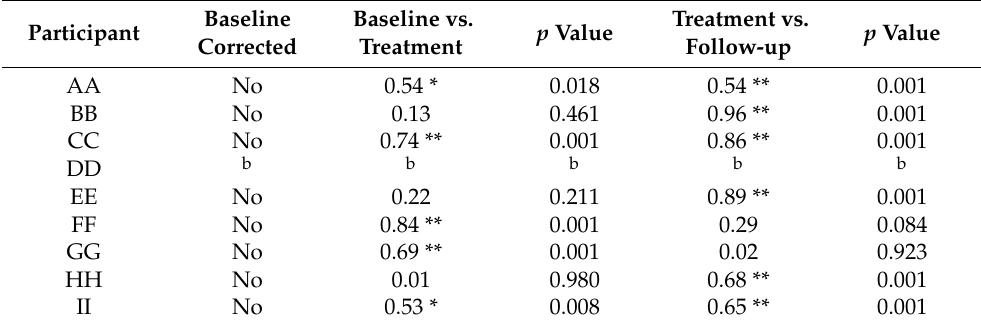
Table 3. Tau-U planned comparison for self-reported ratings of sexuality satisfaction. Baseline Baseline Participant Corrected